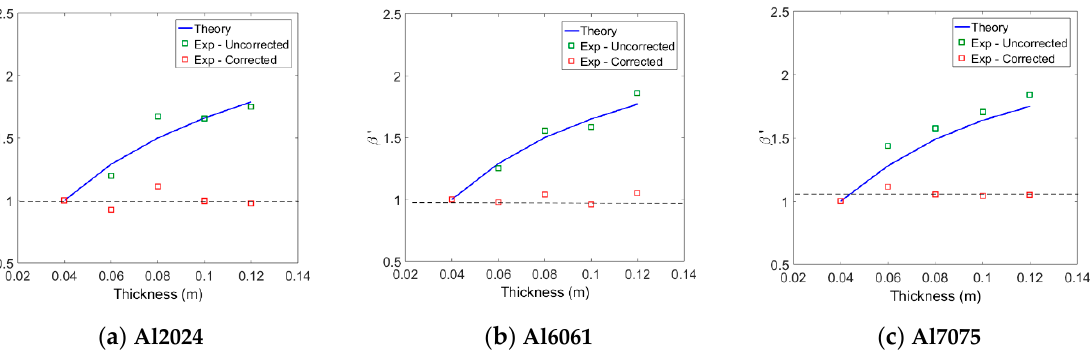
Figure 9. Comparison of normalized β′ between the experiments and theory.